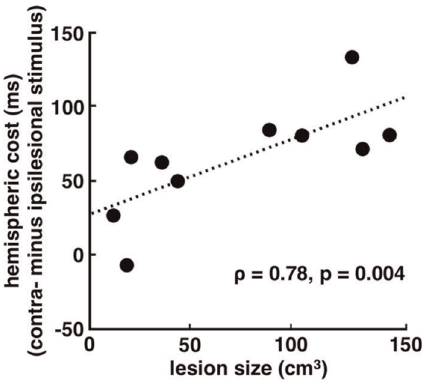
Figure 4. Lesion Size Correlates with Patient Behavior. Patients with larger lesions show a greater behavioral difference between ipsilesion and contralesion stimuli during the mask condition. When a mask is present, patients with the largest lesions show the most slowing when responding to contralesional stimuli (Spearman’s r =0.78,